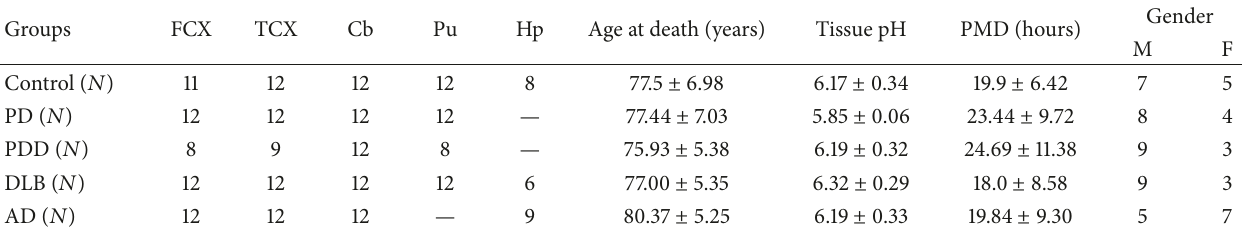
Table 1: Details of brain samples used for Western blot and